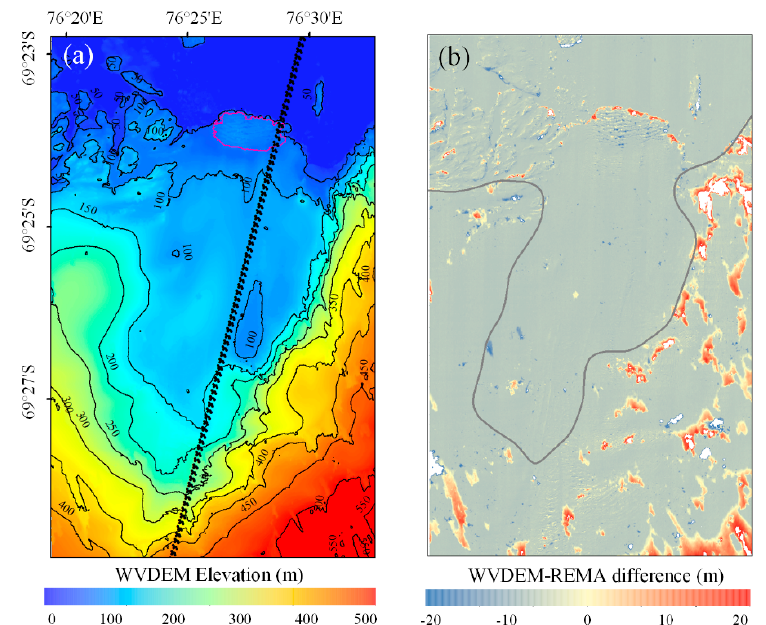
Figure 5. ( a ) Surface elevation of Dalk Glacier. Black lines are contours with 50-m intervals. Black dots are footprints of ICESat data. The pink line donates the possible ice rumple border. ( b ) Elevation di ff erence between WVDEM and the Reference Elevation Model of Antarctica (REMA). The grey line shows the position of the grounding line.